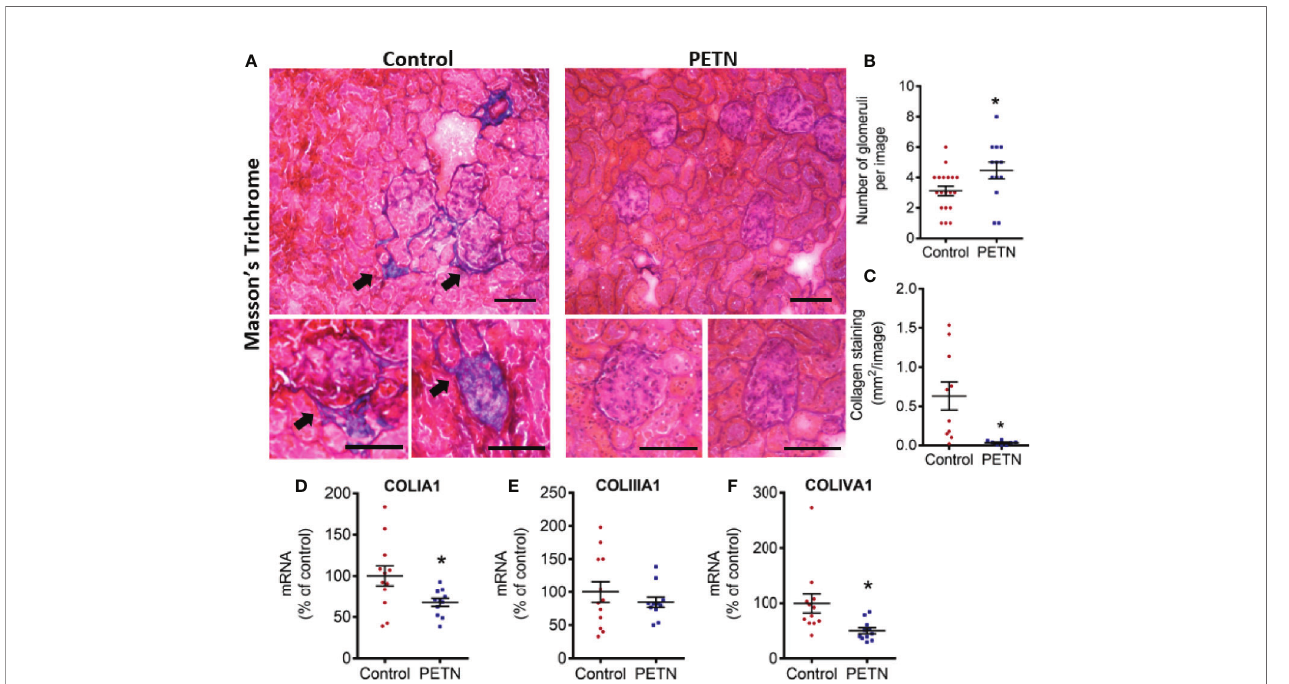
FIGURE 4 | Maternal pentaerythritol tetranitrate (PETN) treatment reduces kidney fi brosis in the female offspring. Parental spontaneously hypertensive rats (SHR) were treated with or without PETN (50 mg/kg/day) during pregnancy and lactation periods. (A) The collagen deposition in the kidney of the 16-week-old female offspring was examined by Masson ’ s Trichrome staining. Blue staining pointed by arrow represents collagen. Representative images were shown. Scale bar, 100 µm. (B) Number of glomeruli was counted. Bar chart represents average counts from 10 images. (C) Collagen deposition around glomeruli was quanti fi ed per image. Bar chart represents average value from 10 images. The gene expression of collagen type 1 (D) , type III (E), and type IV (F) in the kidney of 16-week-old offspring were studied with quantitative real-time PCR. RNA polymerase II was used as reference gene for qPCR. Column represents mean ± SEM. n=11 − 12. Student ’ s t test was used for comparison of PETN group with control group. * P < 0.05, vs. control